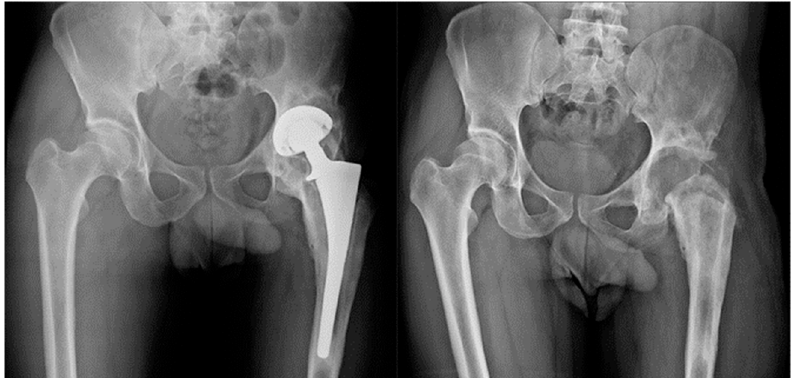
Figure 2. Group B. Patient with communicating sinus tract at the diagnosis. After ex-plantation and targeted antimicrobial therapy for a polymicrobial PJI, the patient was not considered eligible for reimplantation.